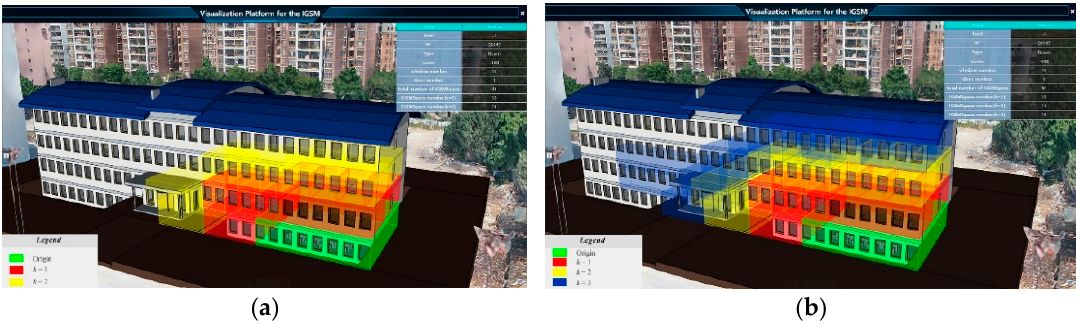
Figure 17. Result of adjacent analysis in the virtual globe (sample data from Table 2. Office Building) ( a ). Result of adjacent analysis on the same floor ( b ). Result of adjacent analysis on the adjacent floor ( c ).